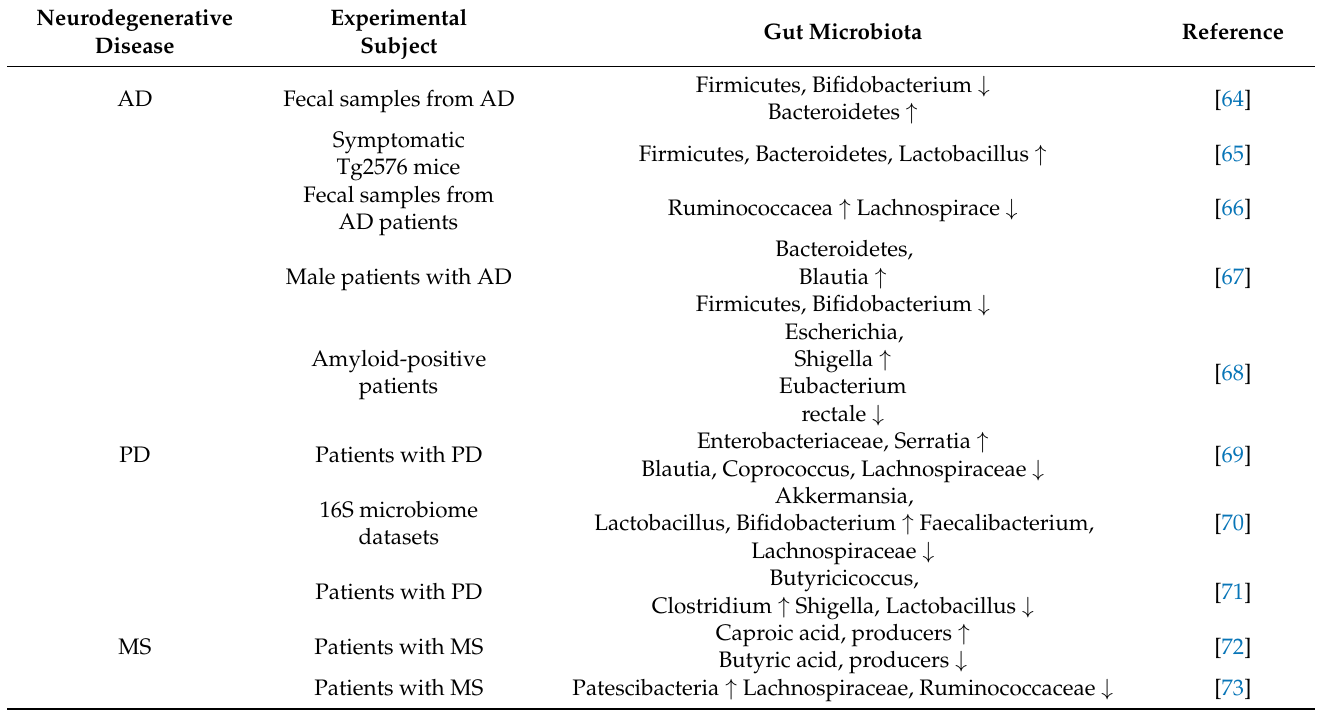
Table 2. Alterations in the gut microbiota composition in various neurodegenerative